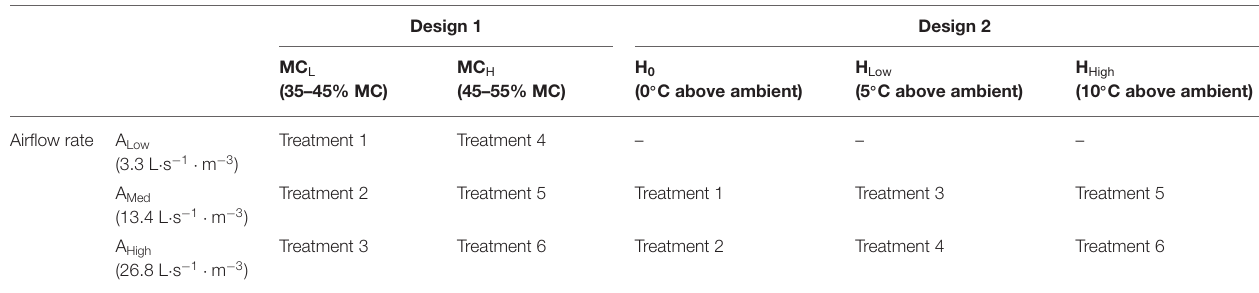
TABLE 2 | NAD factorial design